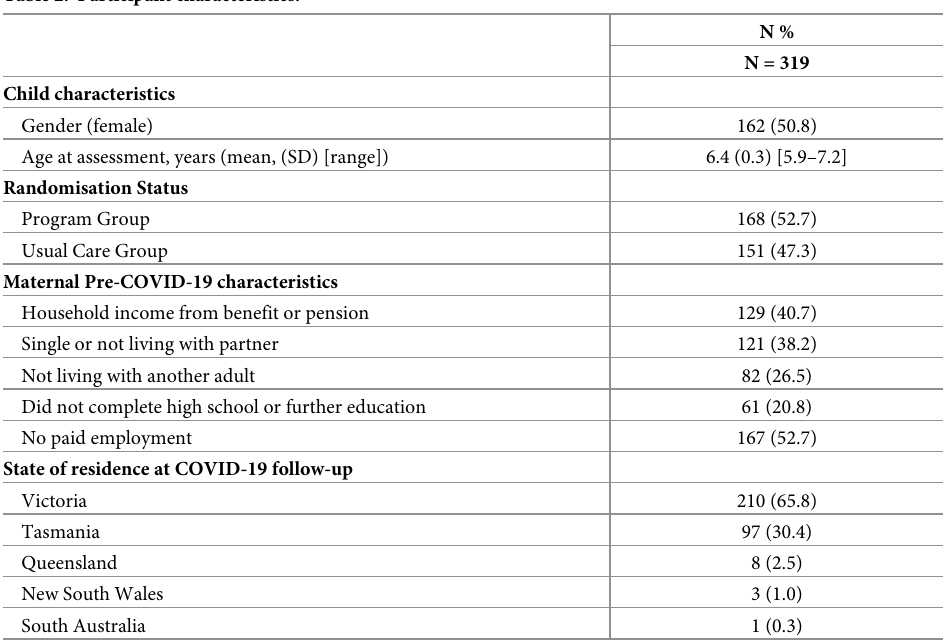
Table 2. Participant